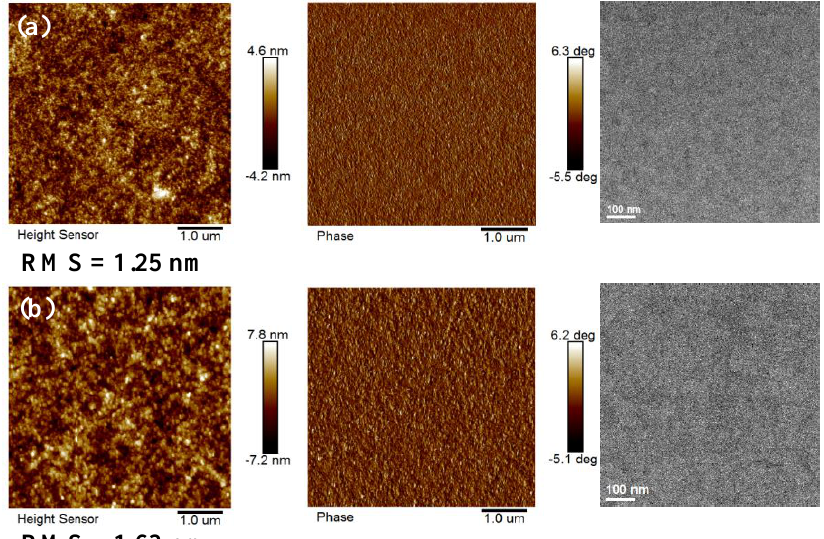
parameters between PBDB-T and IDT-TNIC (as shown in Figure S8). The results are consistent with the device performance characterization.